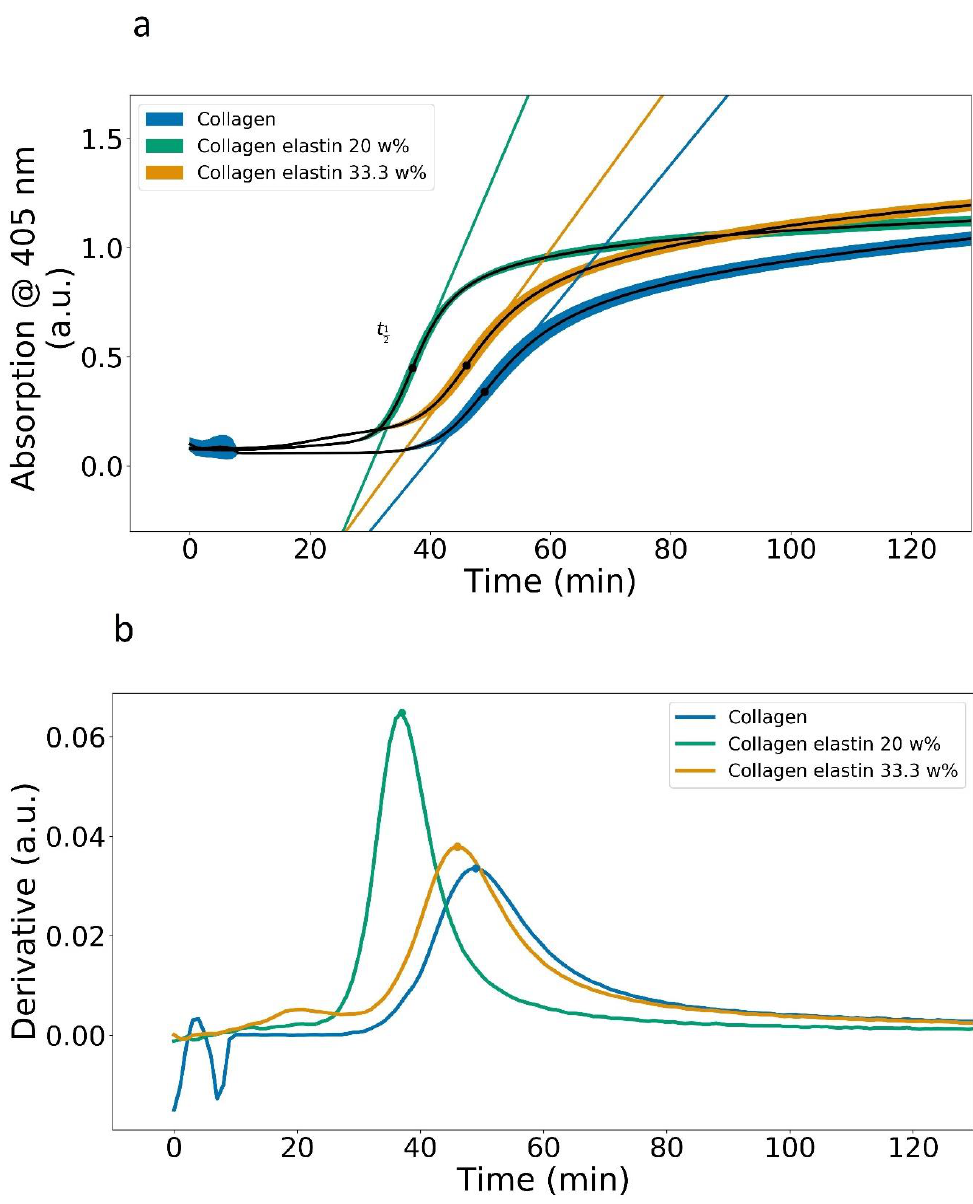
Figure 1. ( a ) Mean polymerization curves at 37 °C for a 2 mg/mL collagen solution as well as two collagen–elastin solutions containing 20 w% (0.6 mg/mL elastin) and 33.3 w% (1.2 mg/mL elastin), respectively. ( b ) Derivative of the mean of the curves in ( a ). Six wells were recorded per sample and the color-coded curves in figure ( a ) denote one standard deviation. Supplementary Figure S3 shows the extended curves. The random spikes in the beginning of the collagen curve result from water condensation and evaporation under the well plate cover. Table 1. Characteristic values for polymerization. 𝑡 1 stands for the time where the derivative of 2 the turbidity curves has the greatest value, i.e., the increase in turbidity is the greatest, while Abs. at t(1/2) (a.u.) stands for the absorption value (turbidity) at the time of 𝑡 1 . 2 Maximum Rate 𝒕 𝟏 (min) Abs. at 𝒕 𝟏 (a.u.) Abs. after 120 min (a.u./Time) (a.u.) 𝟐 𝟐